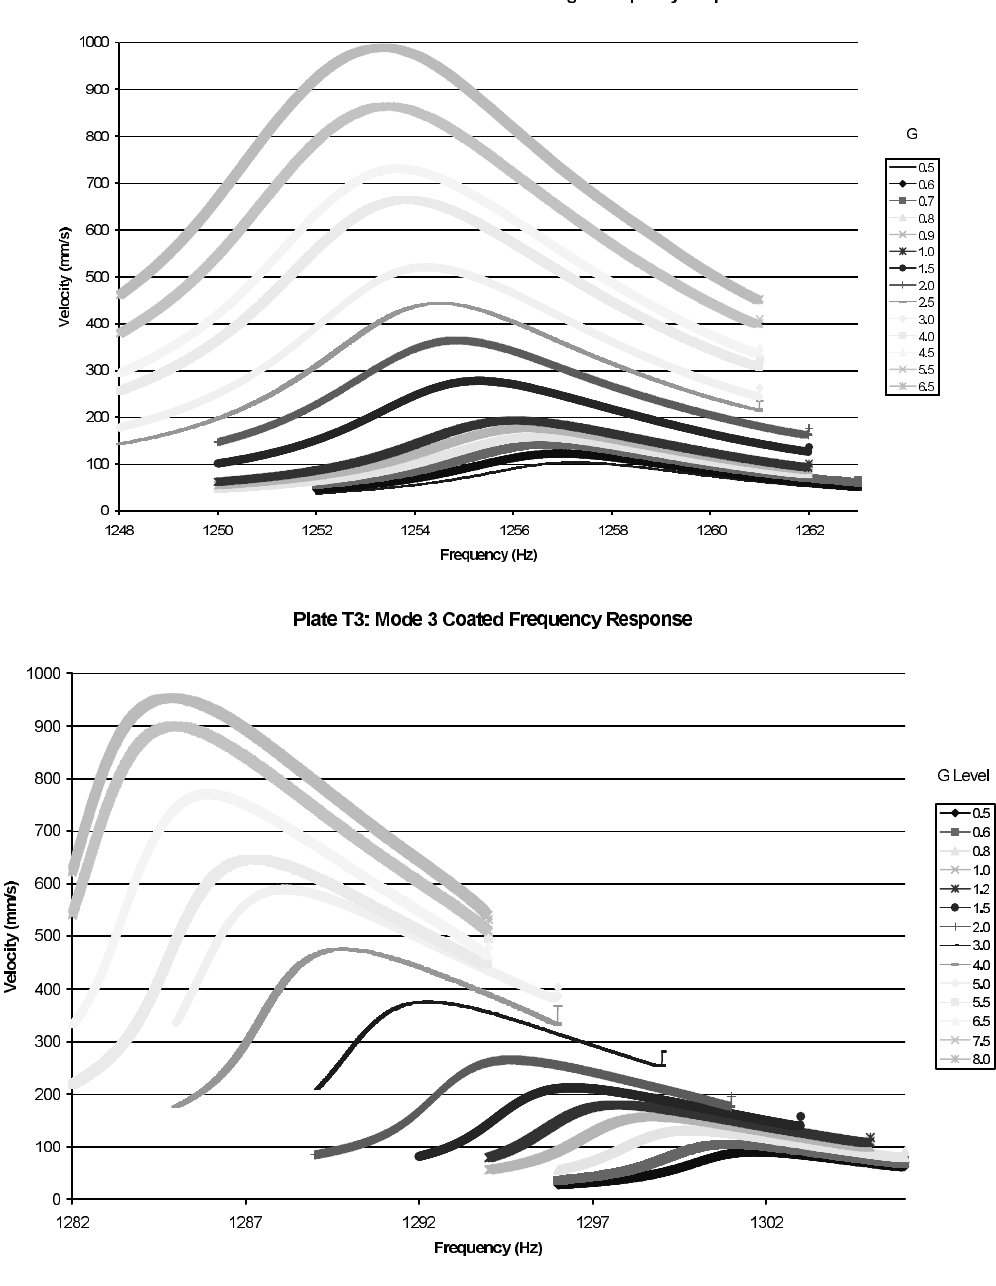
Fig. 7. Sine sweeps for plate T3: Mode 3 Uncoated and